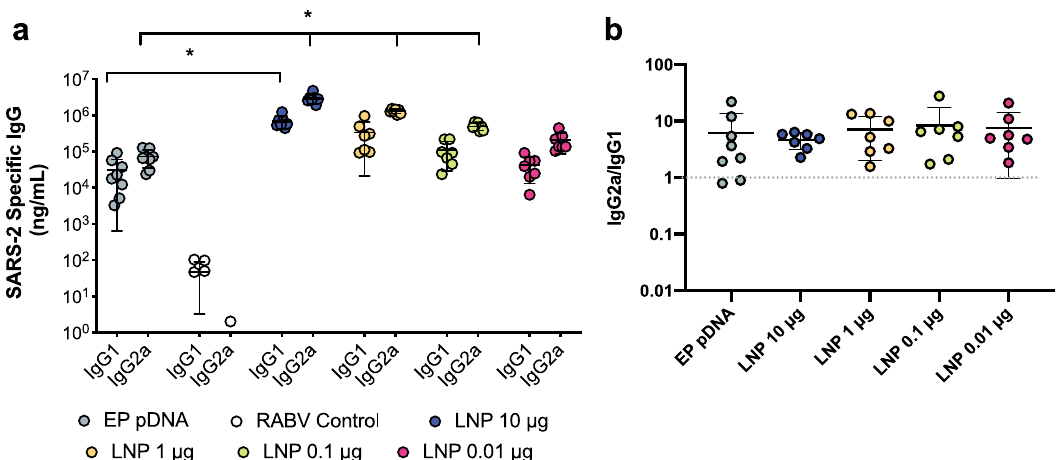
Fig. 2 Th1/Th2 skew in response to SARS-CoV-2 saRNA LNP vaccine. a IgG1 and IgG2a responses in mice vaccinated with doses of LNP-formulated saRNA ranging from 0.01 – 10 μ g of saRNA with n = 7 biologically independent animals, b Th1/Th2 skewing responses in mice vaccinated with doses of LNP-formulated saRNA ranging from 0.01 – 10 μ g of saRNA with n = 7 biologically independent animals, and 10 μ g of electroporated pDNA (EP pDNA) with n = 8 biologically independent animals. The asterisk (*) indicates signi fi cance of p < 0.05 as determined by a Kruskal – Wallis test. Line and error bars indicated mean ±